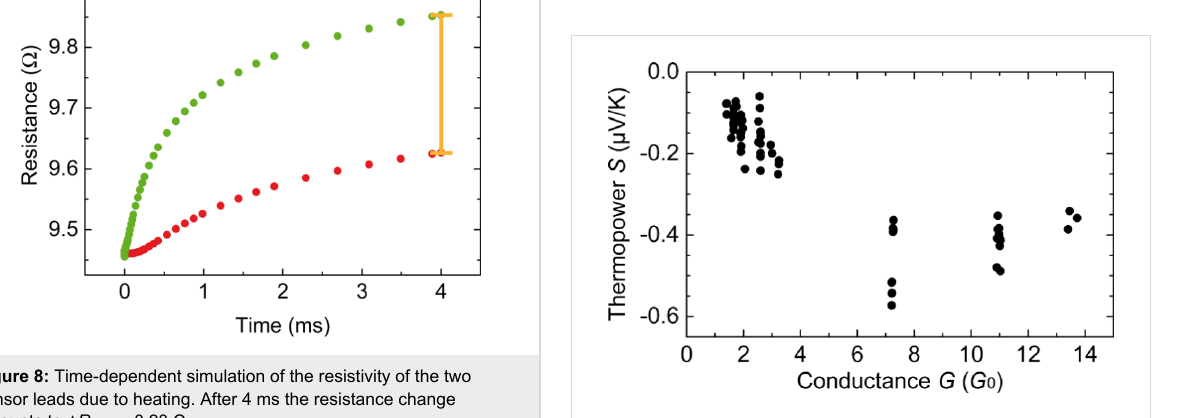
Figure 9: Thermopower S ( G ) versus conductance G of individual contacts, calculated from the ∆ V ( G ) data shown in Figure 5d and the corresponding ∆ T (=7 K) measurement shown in Figure